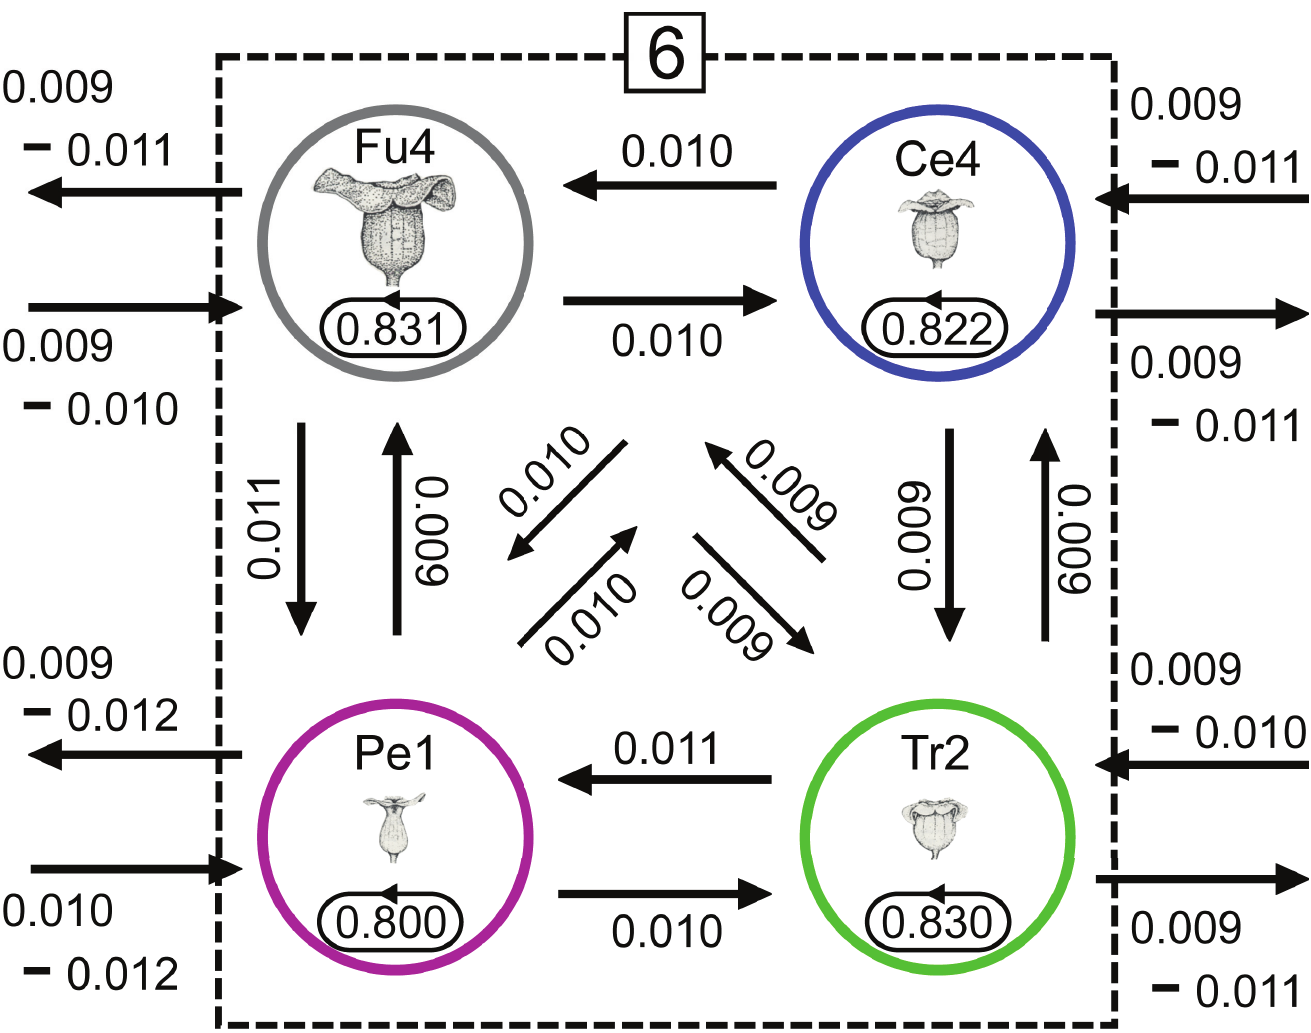
Fig 7. Mean values for the posterior distribution of the migration rate ( m ) of each Asarum population in sympatricstand 6, in which four species grow sympatrically on Amami Oshima. Estimated migrationrates were basedon data for the full set of 12 loci. The stand and population abbreviationscorrespondto those used in Fig 1, S3 Table, S4 Table and S5 Table.